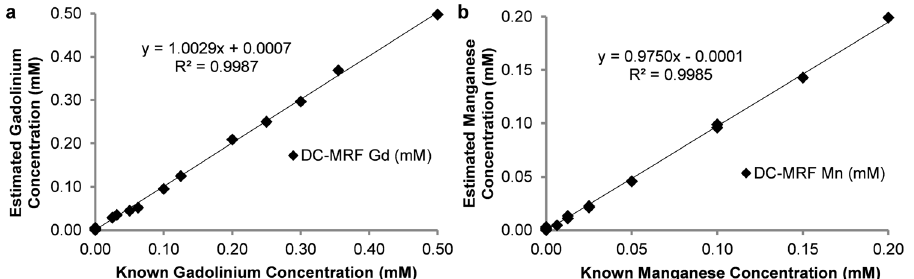
Figure 2. Pearson correlation plots of estimated ( a ) gadolinium (Gd), and ( b ) manganese (Mn) concentration versus known phantom concentrations (n = 17). Estimated concentrations were obtained from equations (3a) and (3b) for data obtained from a 60 MHz relaxometer. Note the significant correlation between the estimated and actual agent concentrations over all phantoms (Pearson Correlation: R 2 > 0.998, two-tailed probability p <